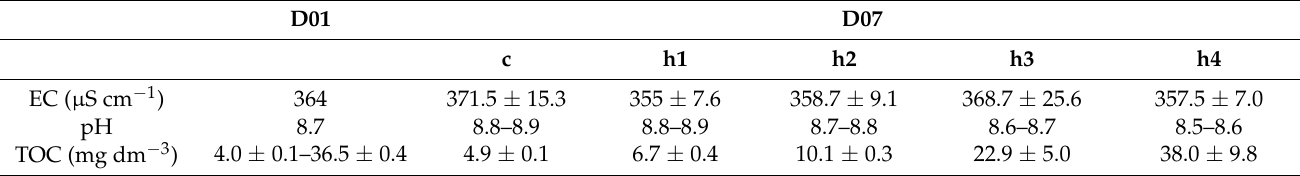
Table 2. Basic parameters of water at the beginning (D01) and at the end (D07) of the